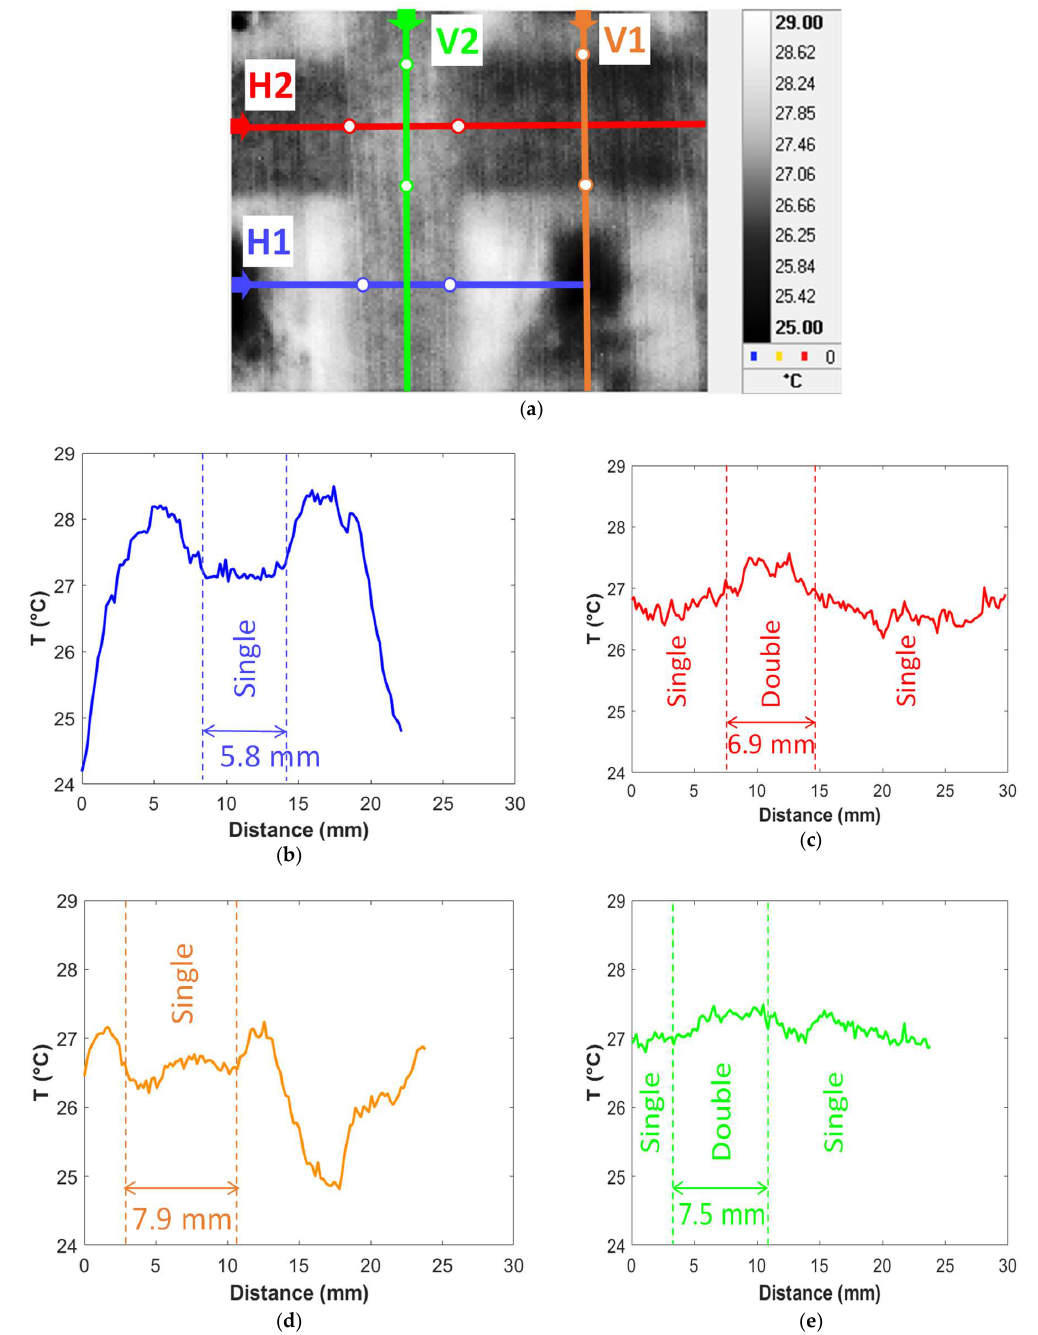
Figure 6. Raw thermal data along linear profiles, at t = 2/472 s: ( a ) profile selection from the thermal map of the ROI. The arrows indicate the origin of each profile, and the white dots are the regions evidenced in the next sub-figures; ( b ) thermal trend along profile H1; ( c ) thermal trend along profile H2; ( d ) thermal trend along profile V1; ( e ) thermal trend along profile